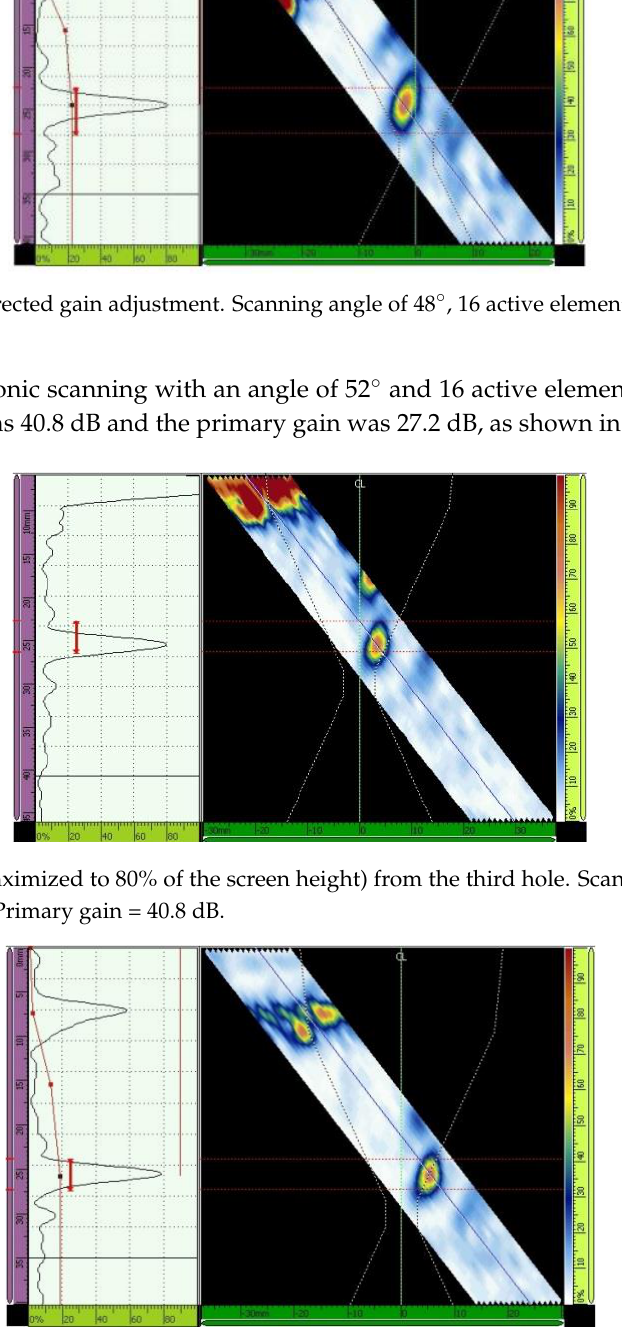
Figure 18. TCG adjustment. Scanning angle of 52°, 16 active elements. Primary gain = 27.2 dB.